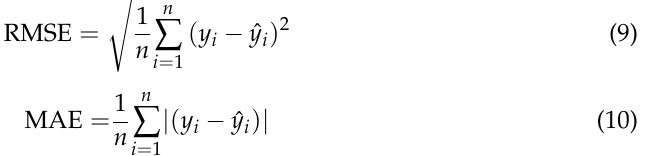
Table 2. Hyperparameters used by the ANN model.